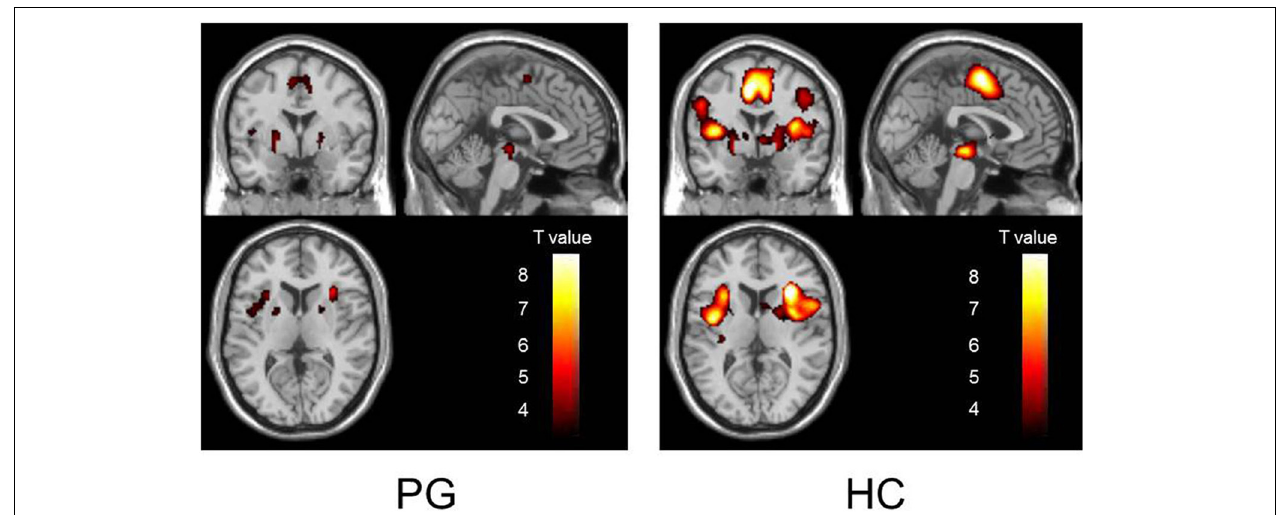
FIGURE 1 | Activation patterns of each subject group during reward anticipation. The activation patterns of PG and HC groups during reward anticipation are shown in the left and right panels,